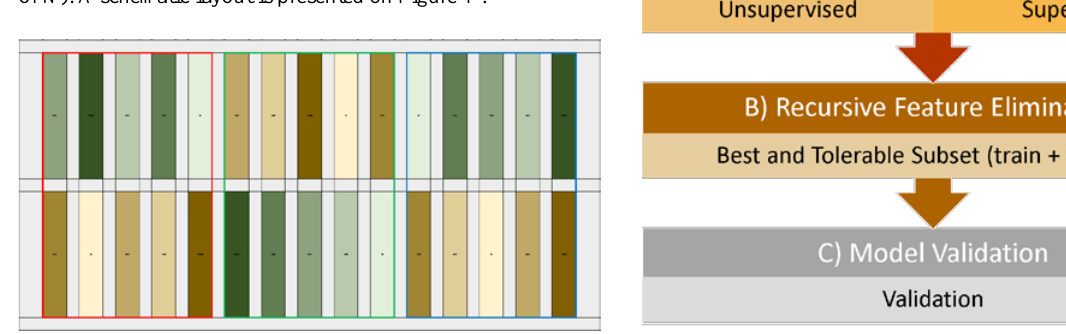
Figure 1- Perennial ryegrass plot layout: colours and shades are linked to growth interval and fertilization level, respectively.